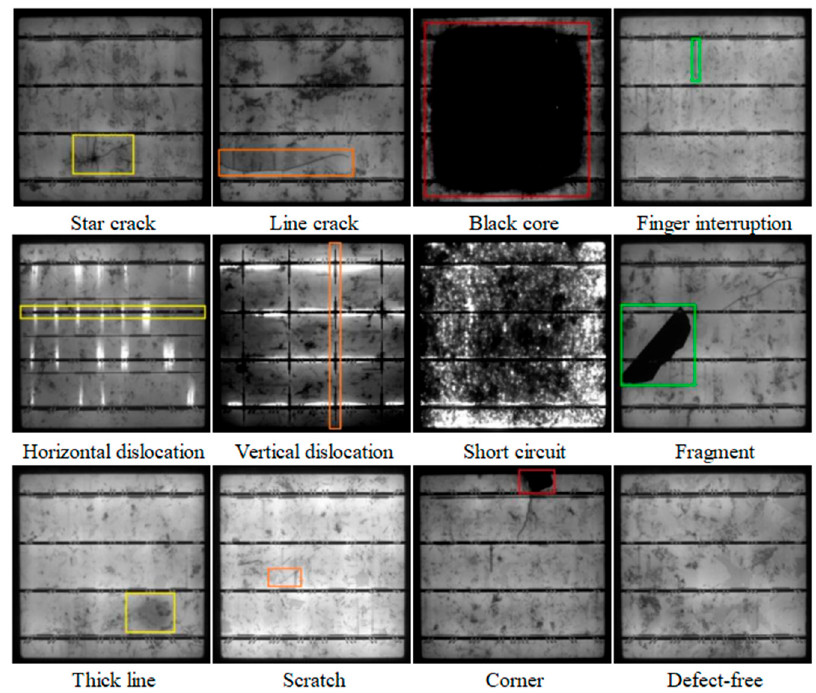
Figure 9. PVEL-AD dataset with 12 different categories of abnormal defects and defect-free images. Table 2. Parameter Table 1. Dataset configuration.